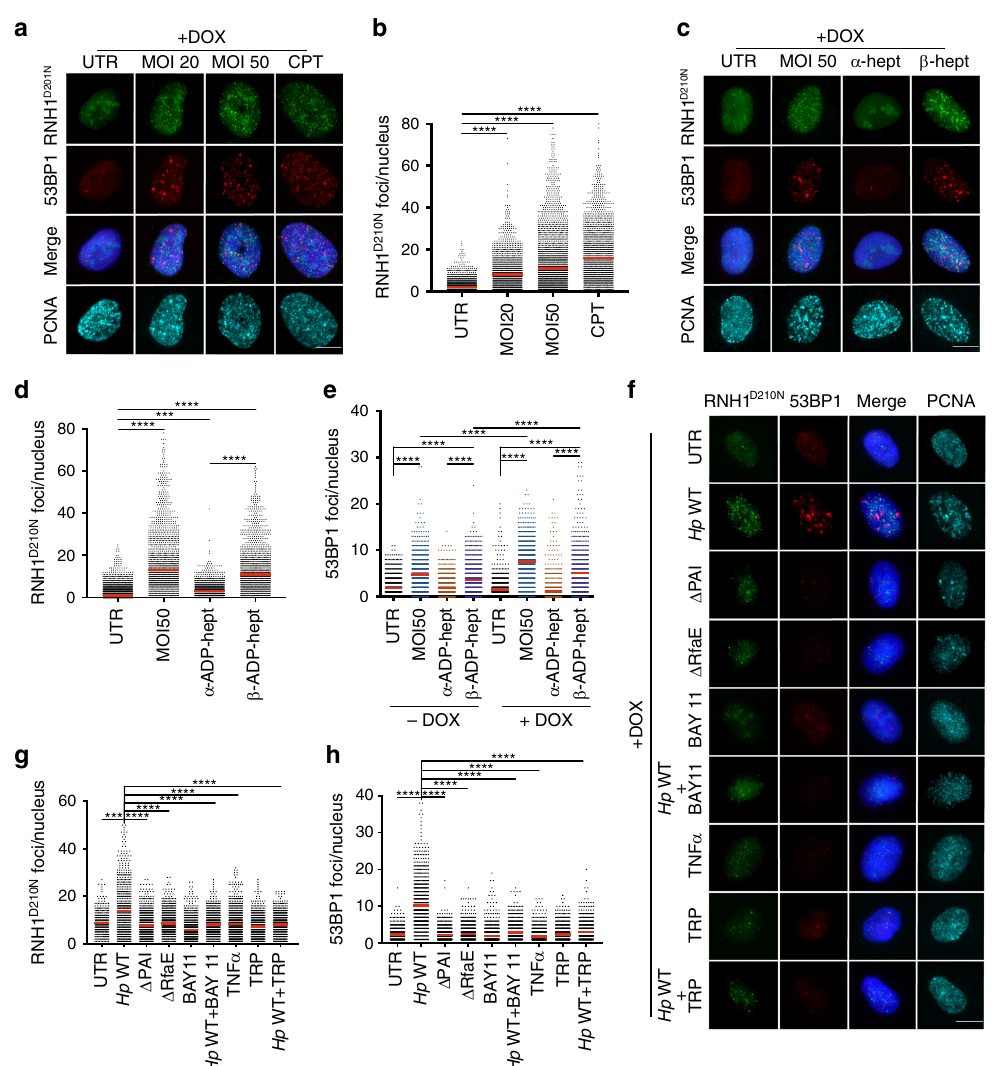
Fig. 6 H. pylori induces R-loop formation that depends on NF- κ B and active transcription. a , b U2OS cells were either infected for 6 h with H. pylori P12 (MOI of 20 or 50), or treated with 100 nM camptothecin (CPT), and were treated or not with doxycycline ( − / + DOX) to induce the expression of a (D210N) mutant version of RNase H1 fused to GFP (RNH1 D210N ). Cells were subjected to immuno fl uorescence staining for 53BP1 and PCNA as well as DAPI. Representative images are shown in RNH1 D210N /GFP foci and 53BP1 foci, alongside scatter dot plots of RNH1 D210N /GFP foci of >1468 and up to 1661 cells per condition in b ; the − DOX panel shows lack of background signal in the GFP channel in the absence of RNH1 D210N /GFP expression. Data in b are pooled from three independent experiments. c , d U2OS cells were infected with H. pylori (MOI of 50) or exposed to α - or β -ADP-heptose at 0.5 μ M fi nal concentration for 6 h and treated or not with doxycycline ( − / + DOX) to induce the expression of RNH1 D210N /GFP. Cells were subjected to immuno fl uorescence staining for 53BP1 and PCNA as well as DAPI. Representative images are shown in c of RNH1 D210N /GFP foci and 53BP1 foci, alongside scatter dot plots of RNH1 D210N /GFP foci of >1326 and up to 1565 cells per condition in d . Data in d are pooled from three independent experiments. e Scatter dot plots showing 53BP1 foci of >1000 and up to 3000 cells per condition of the U2OS cells shown in a and c , and their counterparts not treated with doxycycline. f – h U2OS cells were infected with the indicated strains of H. pylori (MOI of 50) and/or exposed to the NF- κ B inhibitor BAY 11-7082 (1 μ M) or triptolide (100 nM) and treated with doxycycline to induce the expression of RNH1 D210N /GFP. Cells were subjected to immuno fl uorescence staining for 53BP1 and PCNA as well as DAPI. Representative images are shown in f of RNH1 D210N /GFP foci and 53BP1 foci, alongside scatter dot plots of RNH1 D210N /GFP foci of >405 and up to 868 cells per condition in g , and of 53BP1 foci of >691 and up to 1042 cells per condition in h . Data in g and h are pooled from three independent experiments. Red lines indicate medians throughout. P -values were calculated by one-way ANOVA with Dunn ’ s multiple comparisons correction. ns, not signi fi cant; *** p < 0.005, **** p < 0.0001. Scale bars, 10 μ m.